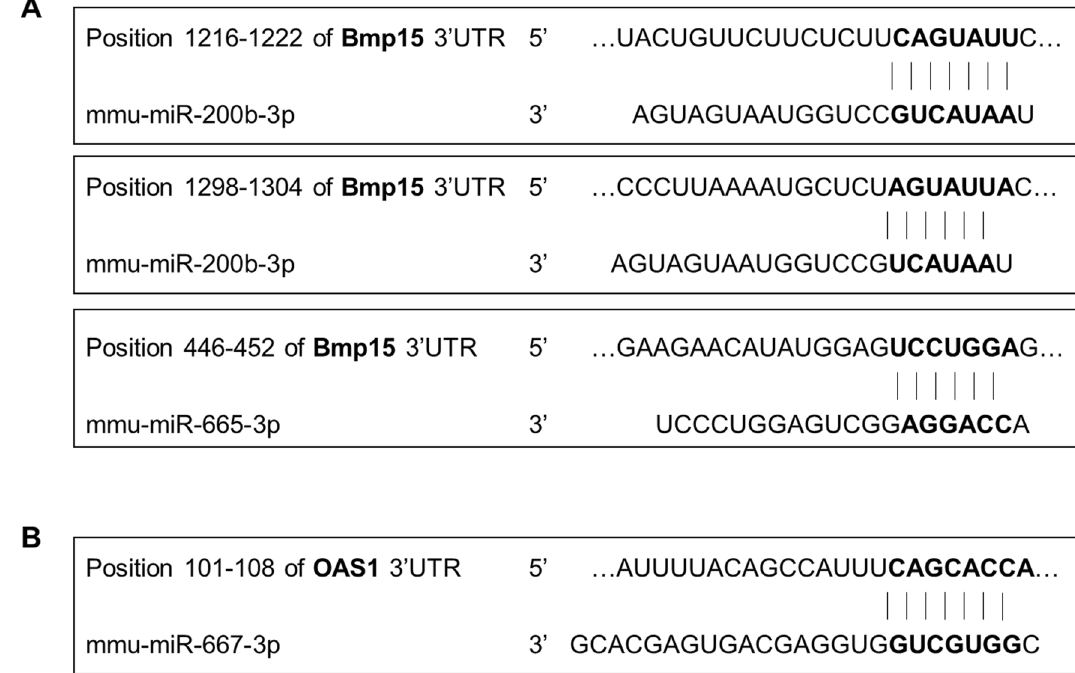
Figure 9. Binding sites between differentially expressed mRNAs and microRNAs. Binding sites in ( A ) Bmp15 for miR-200b-3p and miR-665-3p and ( B ) Oas1 for miR-667-3p, as predicted by TargetScan